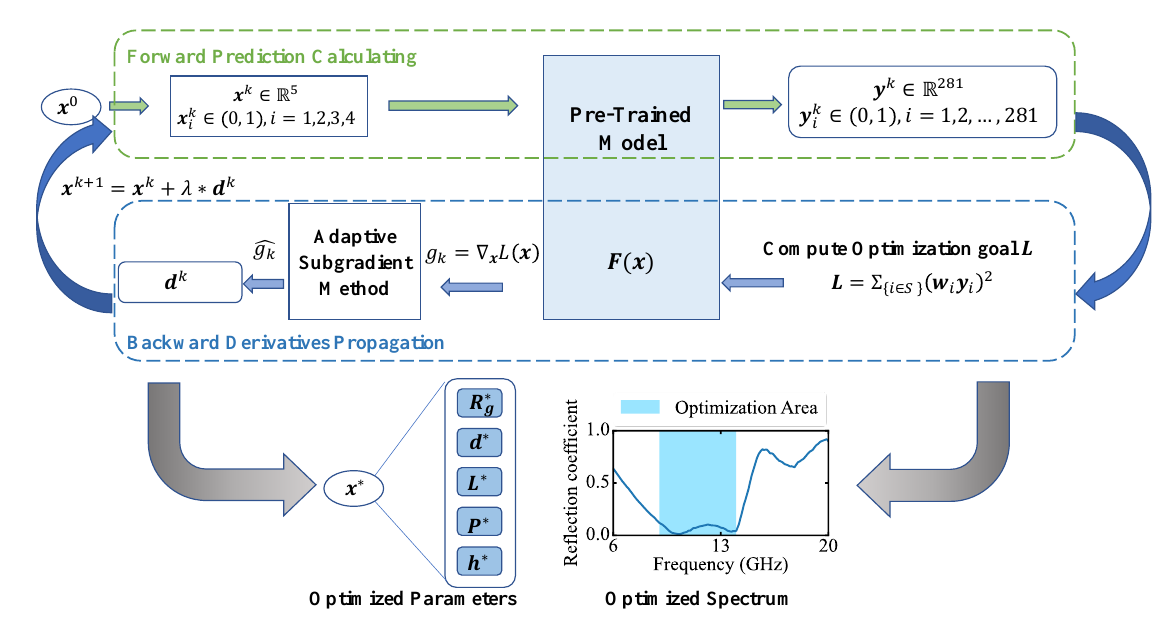
Figure 3. Illustration of inverse design system optimization process. Before training begins, an initial seed x 0 is generated randomly. In iterative step k , loss L and the its gradients to x : g k = ∇ x L ( x ) are firstly computed through the pre-trained model. ˆ g k is derived by the adaptive subgradient method [52] based on g k in all iterations before k-th to determine the desecending direction d k , which is the same dimension as x . λ is the descending step of each iterative, which is a scalar in (0, 1). x is updated with the iterative paradigm. After a fixed number of iterative steps, the optimized result can be then solved. Combinations of optimized parameters of any design requirements can be obtained within